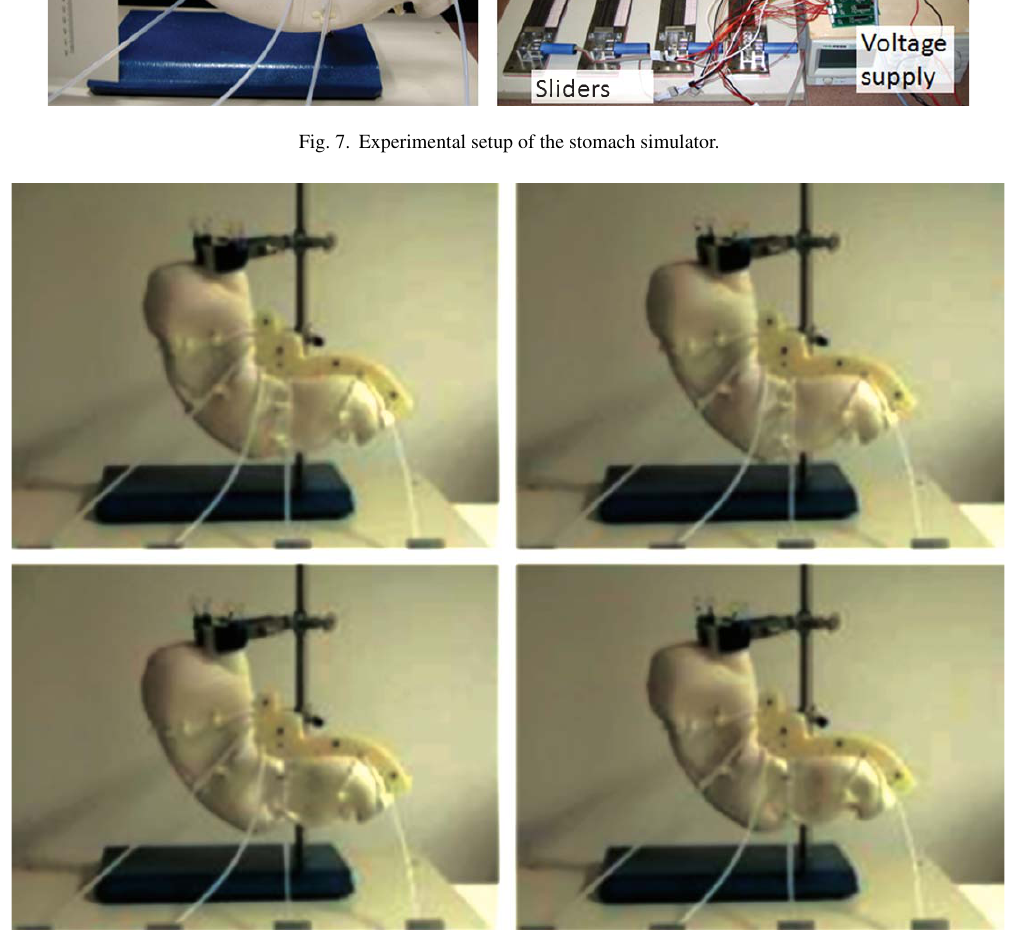
Fig. 8. Motion of the stomach